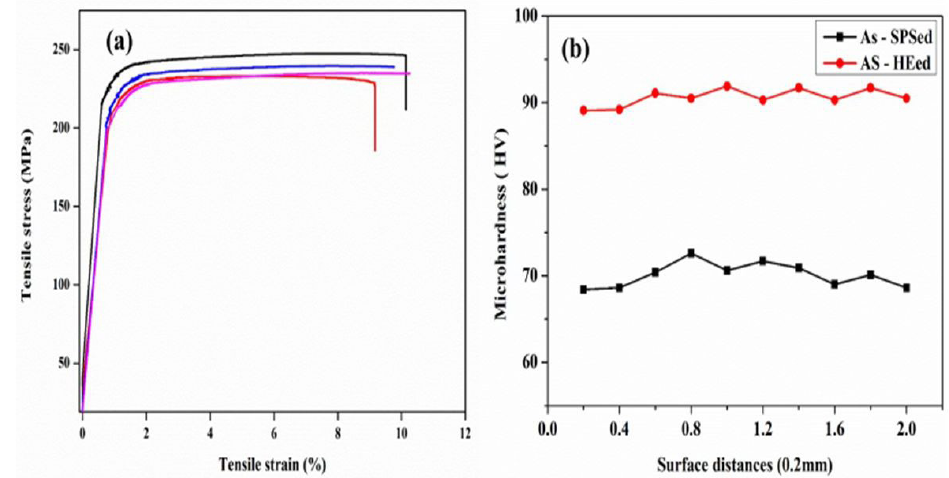
Figure 6. (a) Tensile stress-strain curves of as-extruded sample and (b) Vickers microhardness profile over 02 mm surface distances.